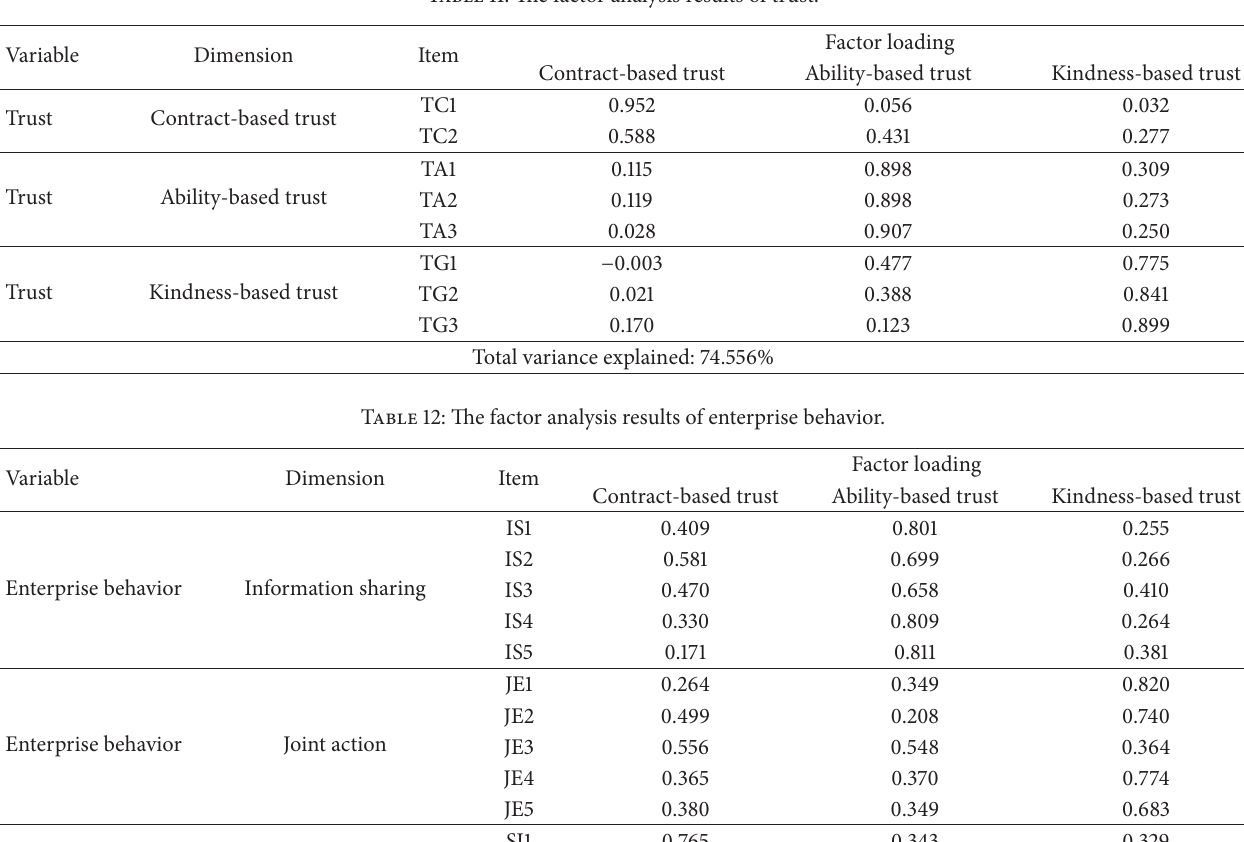
Table 11: The factor analysis results of trust.